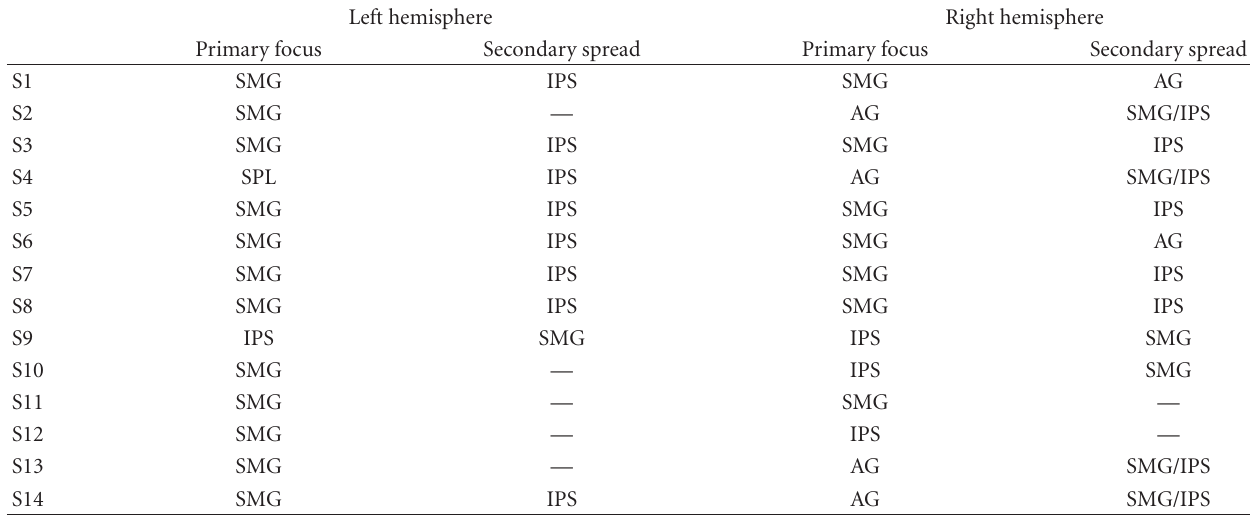
Table 2: Regions of primary focus and secondary spread for parietal ROIs associated with the High-Attention condition in each of the 14 subjects. Left hemisphere Right hemisphere